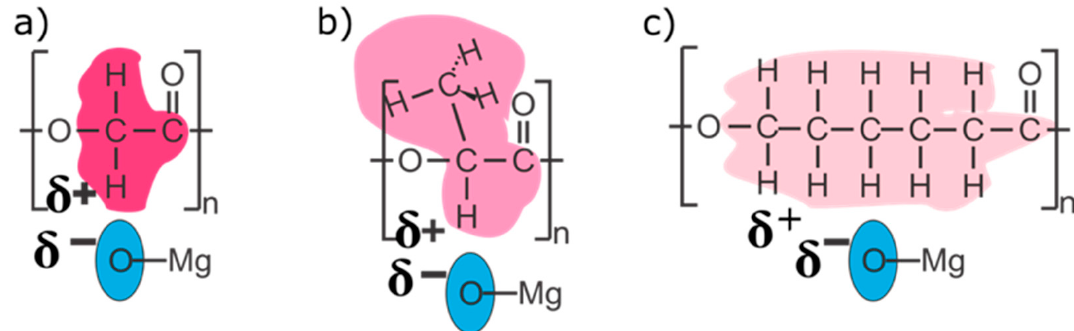
Figure 9. Interphase interactions inside the three different composites: ( a ) MgO/PLGA (only interactions with the PGA part shown), ( b ) MgO/PLA and ( c ) MgO/PCL.